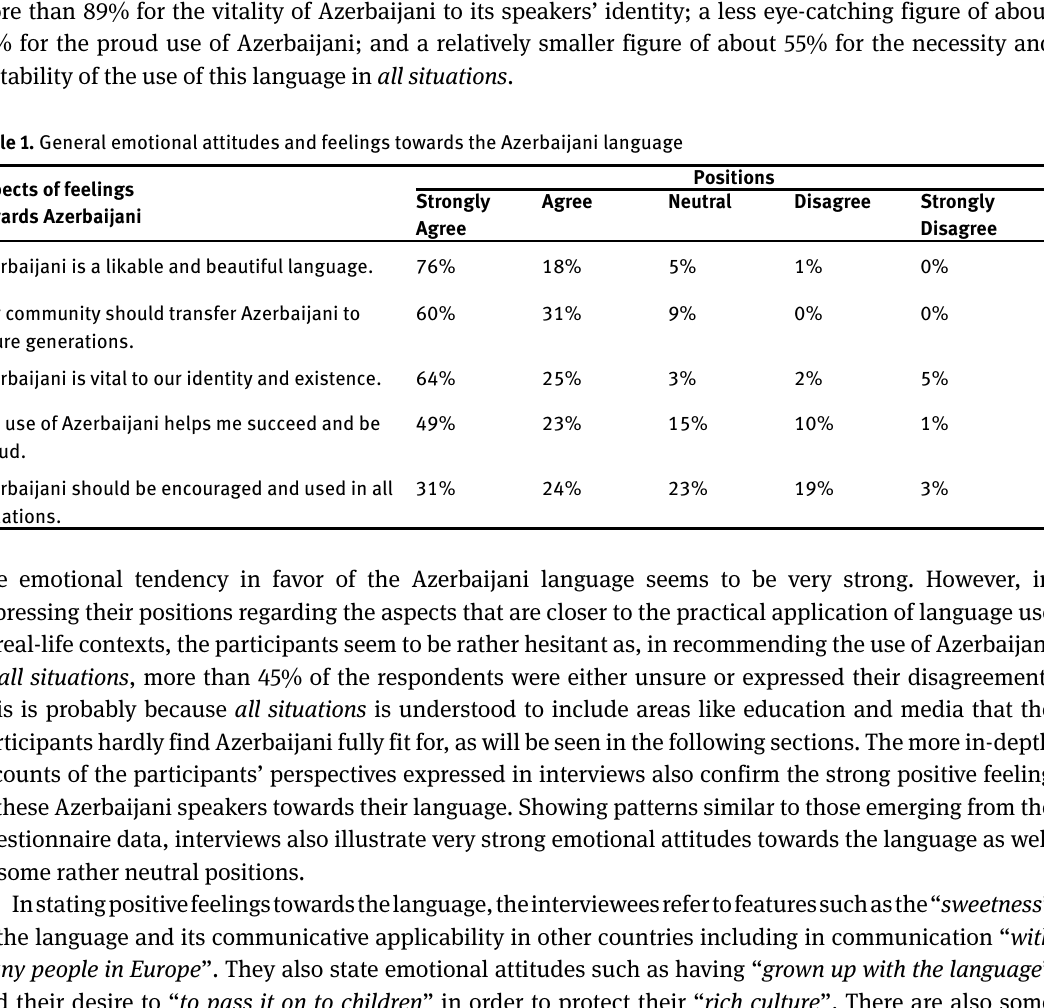
Table 1. General emotional attitudes and feelings towards the Azerbaijani language Aspects of feelings towards Azerbaijani Azerbaijani is a likable and beautiful language.